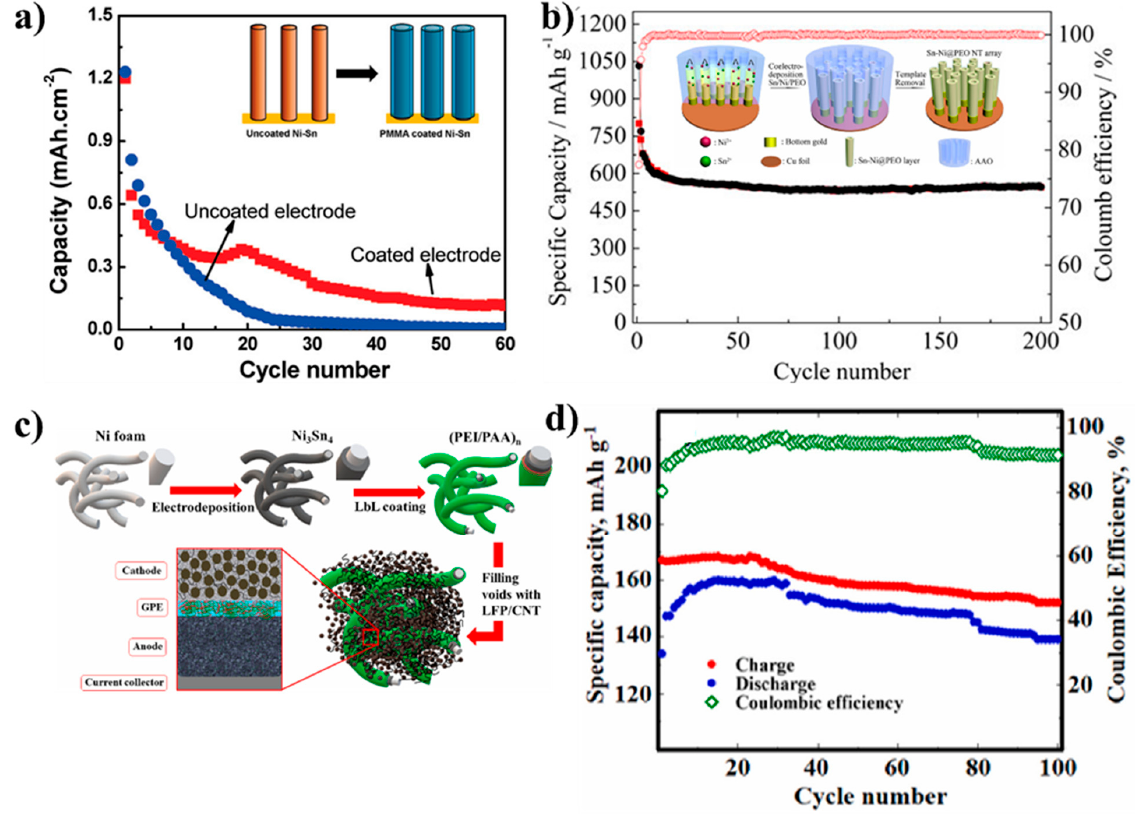
Figure 8. ( a ) The cycling performance of PMMA-polymer-coated Ni − Sn and bare Ni − Sn nanowires. The three-dimensional PMMA-coated Ni − Sn nanowires (in blue color) and the uncoated Ni − Sn nanowires cycled (in red color) at the rate of 0.3 mA cm − 2 (or 3.0C). Reproduced from Ref [130] with permission from the American Chemical Society. ( b ) A schematic representation of the Sn–Ni@PEO nanotube formation. Reproduced from Ref [128] with permission from the American Chemical Society. ( c , d ) A 3D full battery fabrication consists of the Ni 3 Sn 4 alloy as an anode material and LiFePO 4 (LFP) as a cathode at 0.1C. Reproduced from Ref [36] with permission from Elsevier.